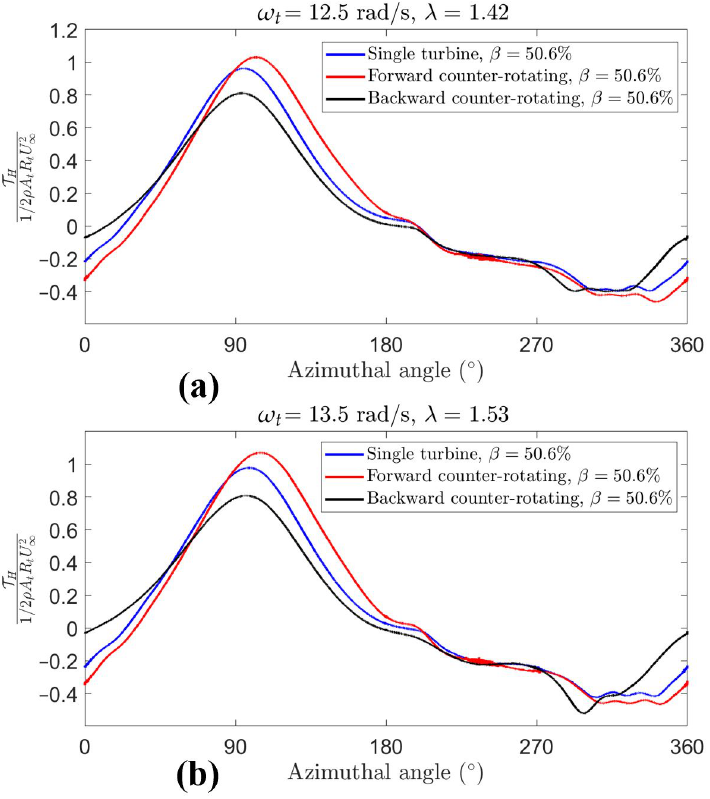
Figure 20. The torque curves of the single and twin turbine configurations at λ = 1.42 ( a ) and λ = 1.56 ( b ).